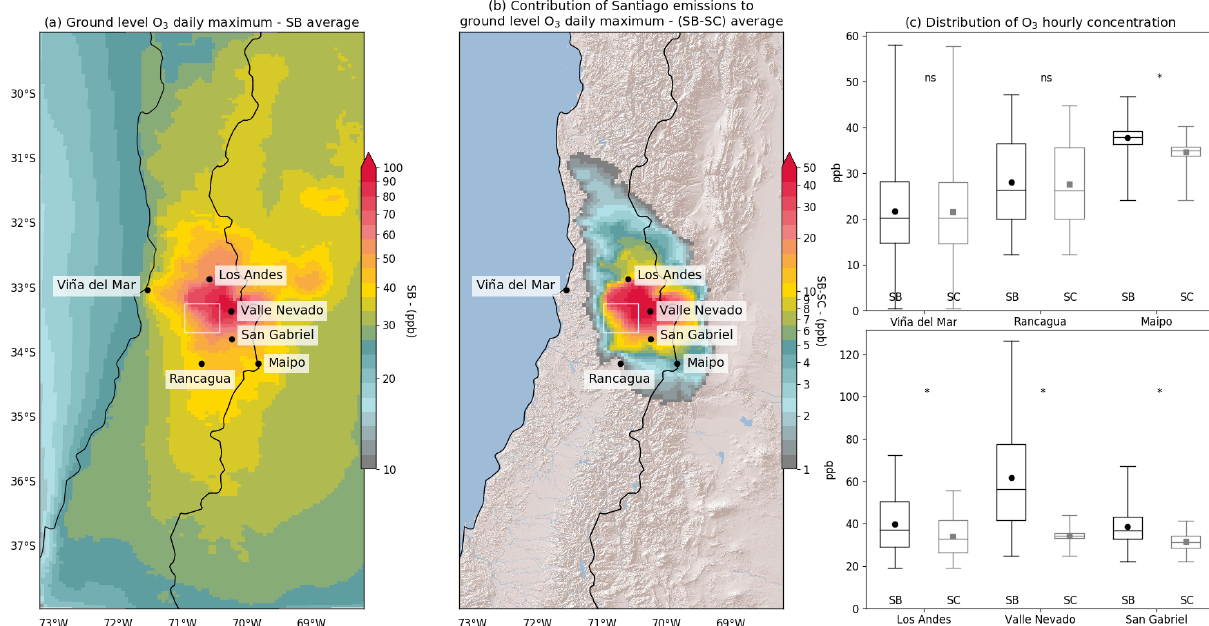
Figure 5. (a) Ground-level O 3 average daily maximum of hourly mixing ratio in scenario SB. (b) Difference between SB and SC ground- level O 3 average daily maximum of the hourly mixing ratio. (c) Distribution of hourly O 3 mixing ratio at six locations in scenarios SB (black) and SC (gray); horizontal lines are quartiles, whiskers show the minimum and maximum, and dots show the average; ns indicates that the distribution in the SB and SC scenarios cannot be distinguished at the 90% level based on a t test. The asterisk ( ∗ ) indicates that they are different at the 99% level, based on that same t test. Map background layer source: World Shaded Relief, ©2009